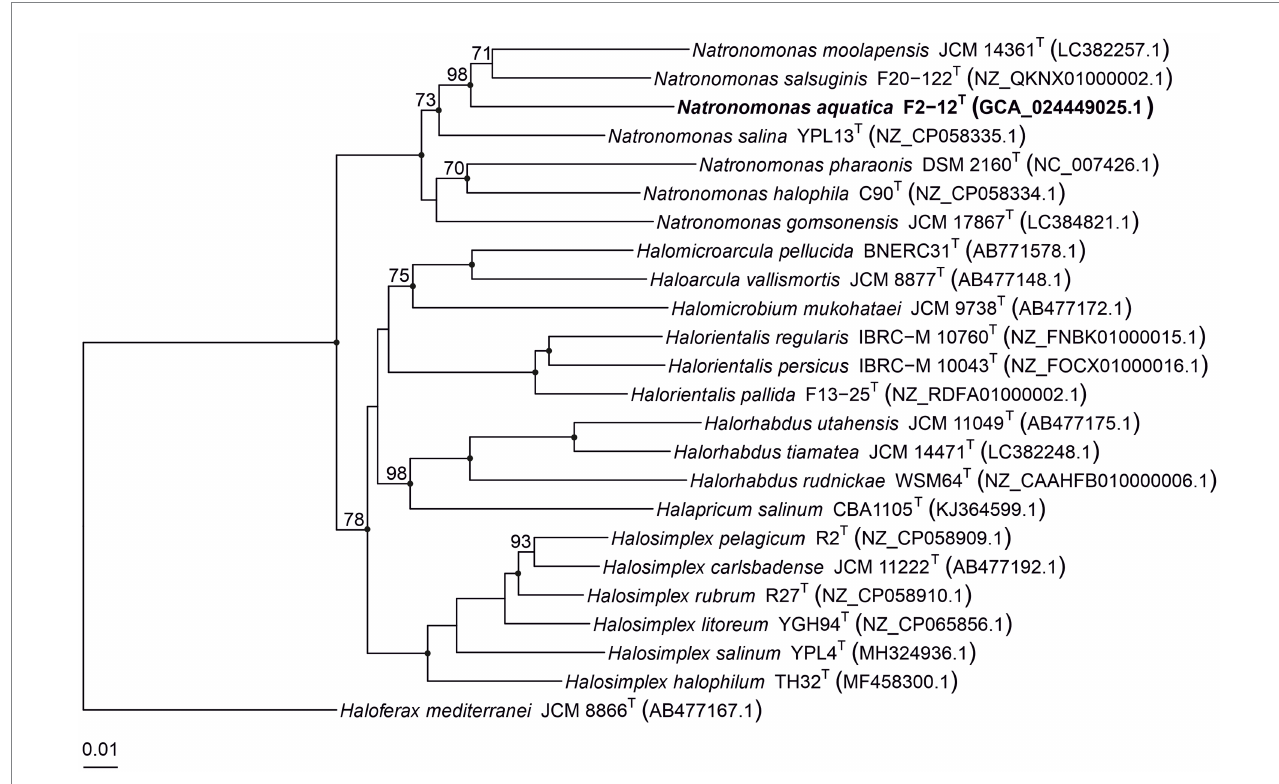
FIGURE 4 Maximum-parsimony phylogenetic tree based on the comparison of rpoB ’ gene sequences showing the phylogenetic relationship between strain F2-12 T , the species of the genus Natronomonas and other related haloarchaeal genera. The sequences accession numbers are shown in parentheses. Bootstrap values equal or higher than 70% are indicated above the nodes. Black circles indicate that the corresponding nodes were also obtained in the trees generated with the maximum-likelihood and neighbor-joining algorithms. Haloferax mediterranei ATCC 33500 T was used as outgroup. Bar, 0.01 substitutions per nucleotide